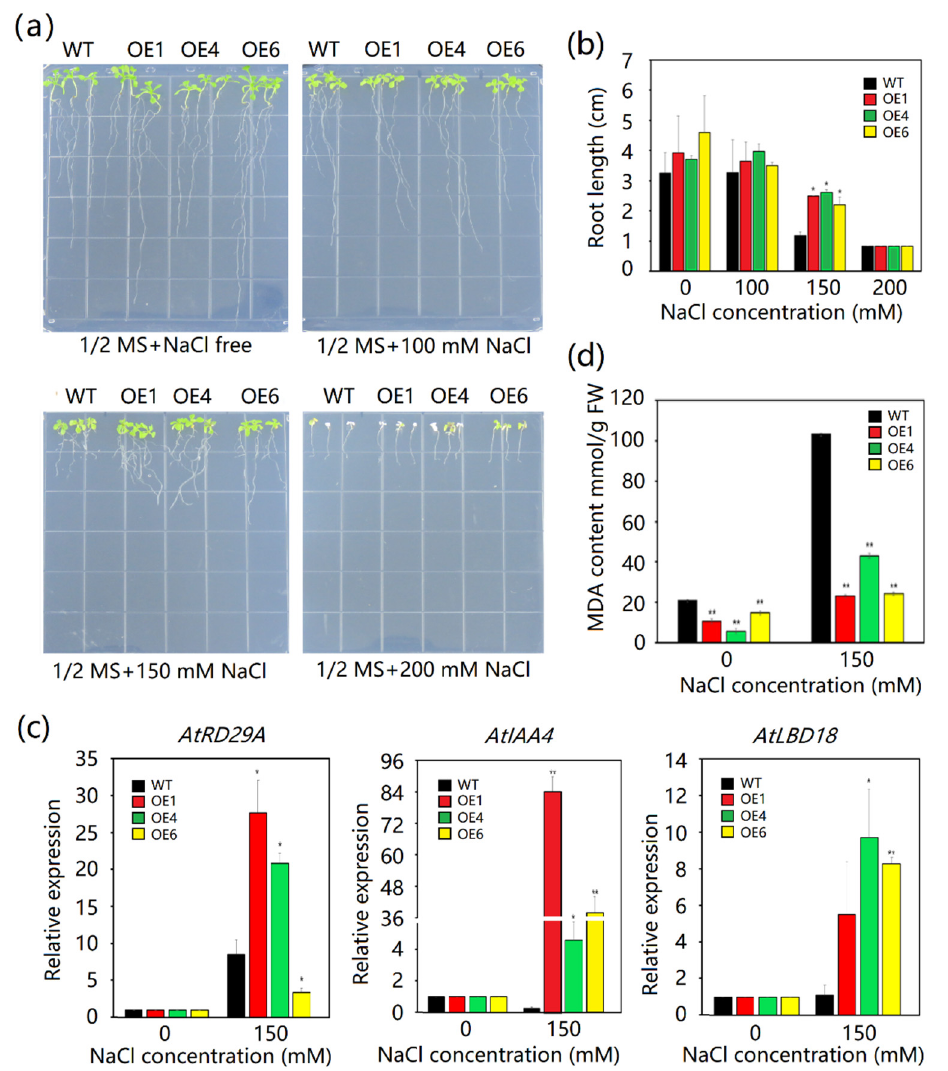
Figure 6. Evaluation of salt resistance in MeAnn2 OE plants. ( a ) Phenotypes of transgenic Arabidopsis under different NaCl concentration gradient stresses. ( b ) Root length of transgenic Arabidopsis under different NaCl concentration gradient stresses. ( c ) The expression of stress resistance-related genes under 150 mM NaCl stress. ( d ) MDA content under 150 mM NaCl stress. Error bars indicate ± SD. *, n = 3, p ≤ 0.05; **, p ≤ 0.01.